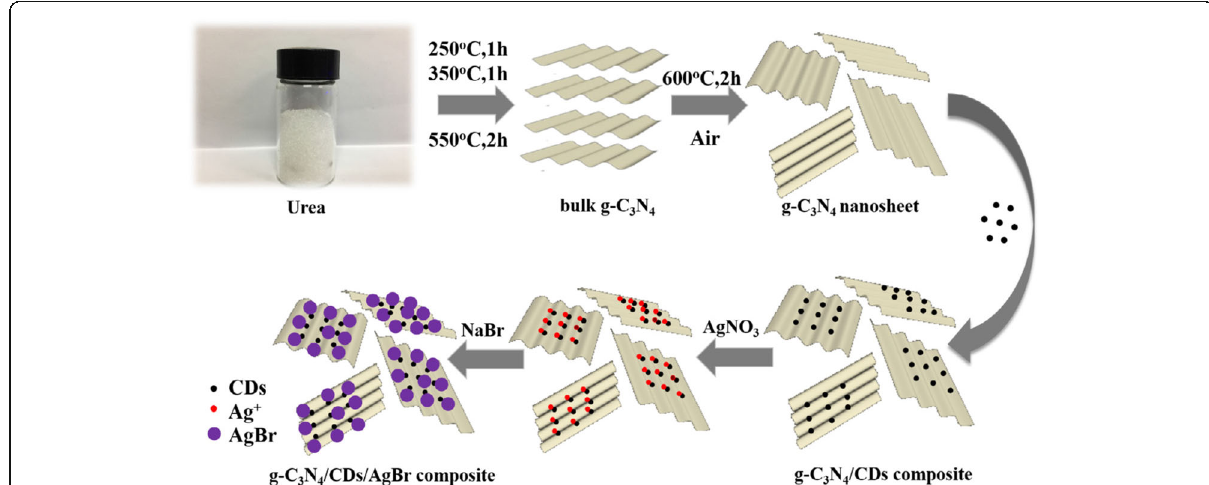
Fig. 10 Schematic illustration of preparation process of the g-C 3 N 4 /CDs/AgBr nanocomposite. Reproduced with permission [86]. Copyright 2017 Elsevier